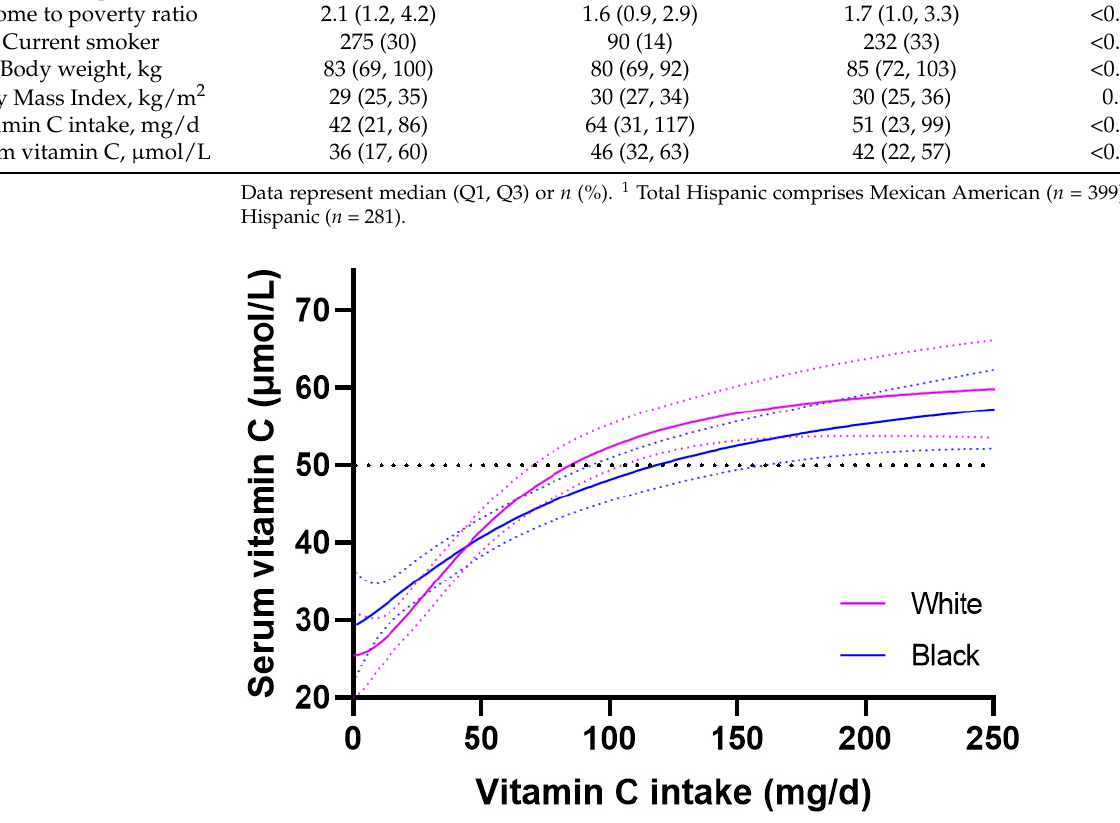
Table 7. Cohort characteristics stratified by socioeconomic status.